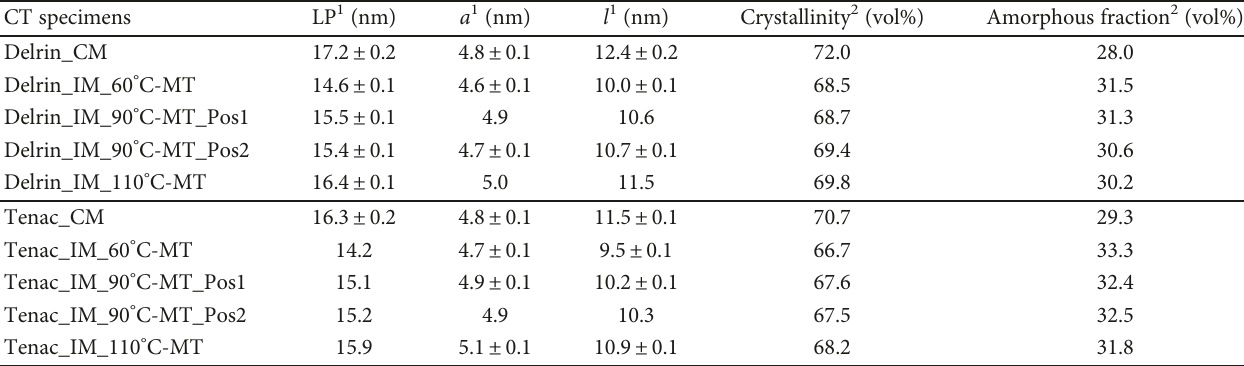
Table 6: SAXS measurements of the CT specimens analyzed using 1D correlation ( LP is the long period, a is the thickness of the amorphous layer, l is the lamellar thickness of the crystalline lamella).